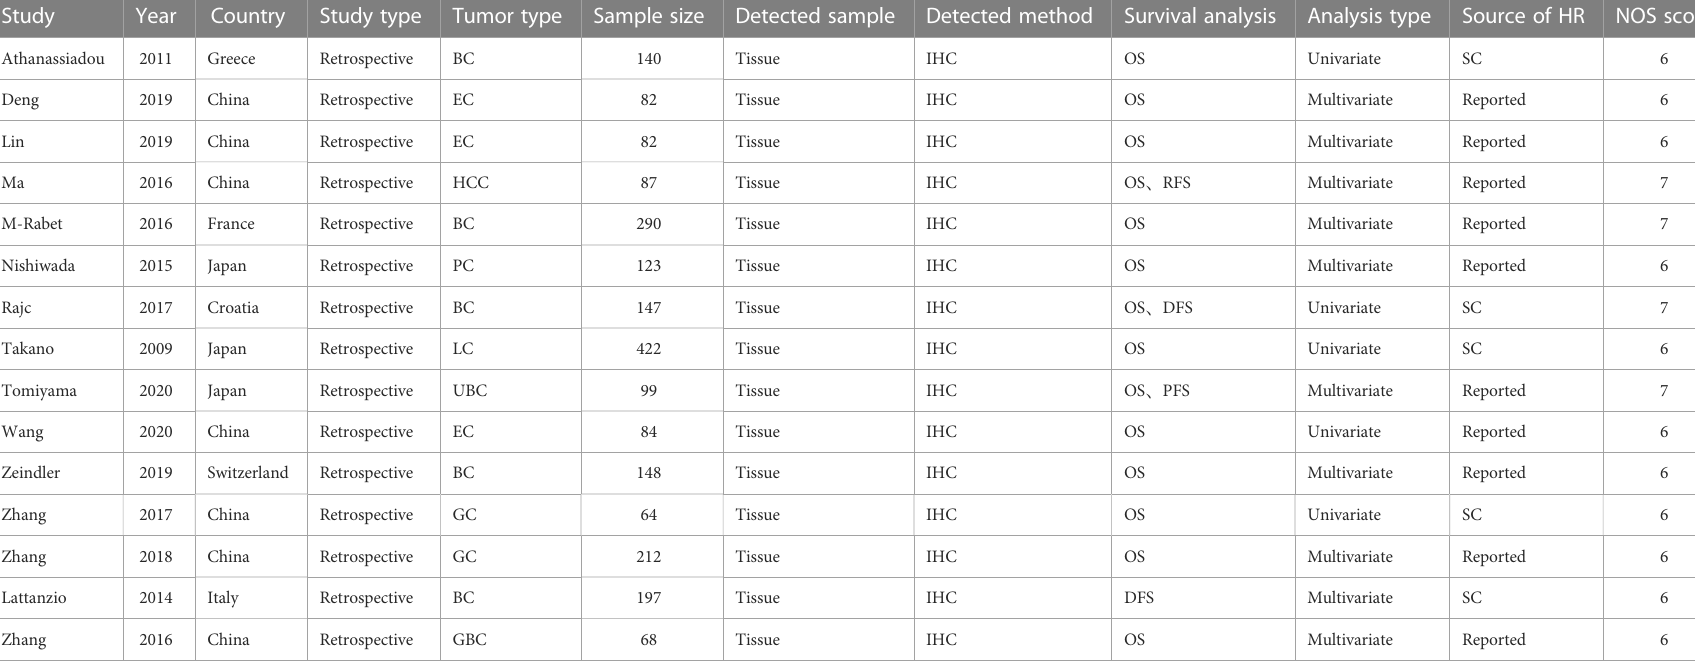
TABLE 1 Basic information of included